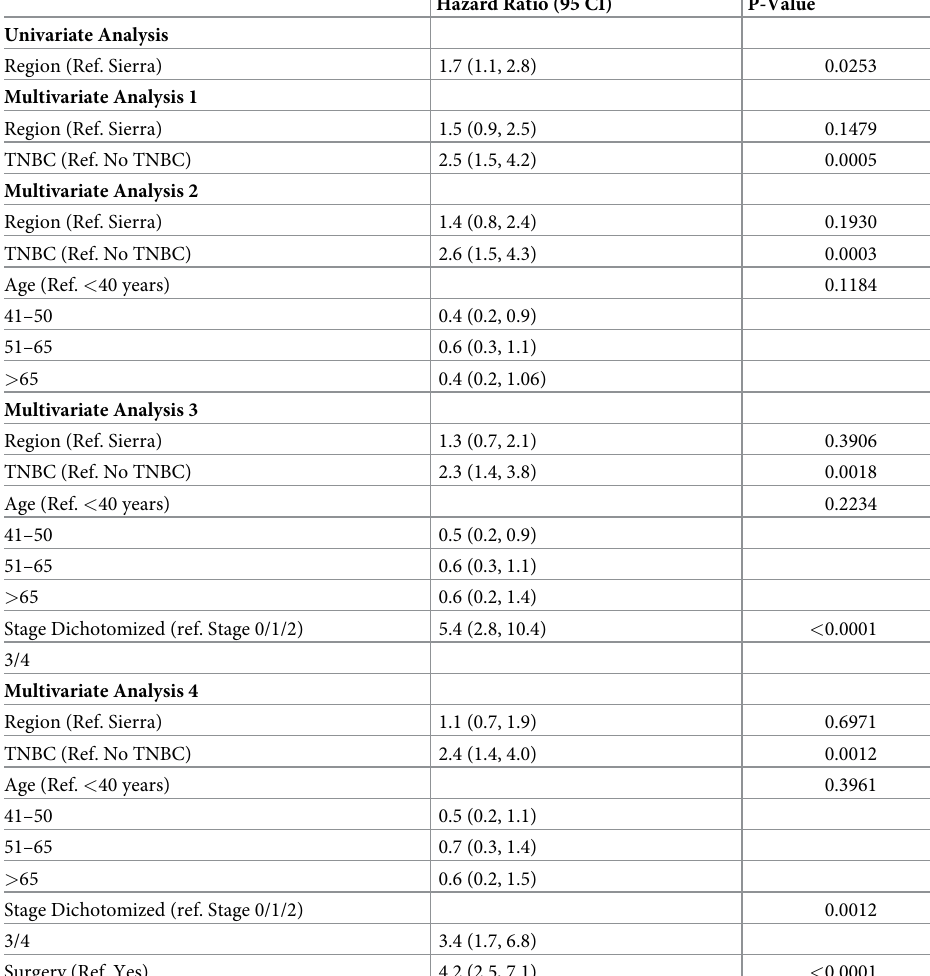
Table 2. Association between geographical region and survival in Peruvian Indigenous American Women with breast cancer,